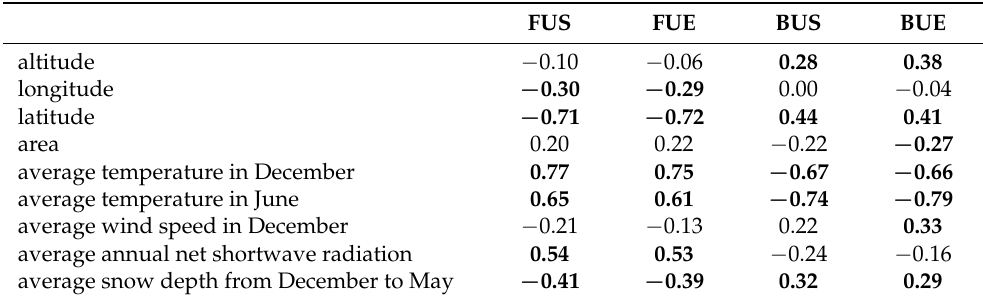
Table 3. Correlation coefficients between lake ice phenology parameters and influencing factors. The black bold numbers represent the statistical significance at the 0.1 level ( t -test). FUS FUE BUS BUE altitude − 0.10 0.38